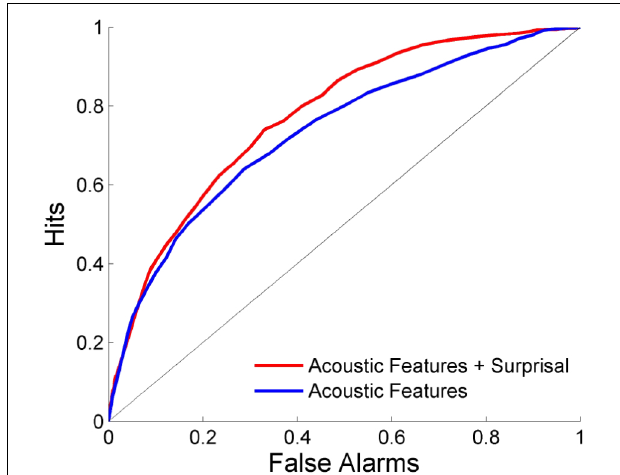
FIGURE 5 | Event prediction performance. Predictions are made using LDA on overlapping time bins across scenes. The area under the ROC curve is 0.775 with a combination of acoustic features and surprisal, while it reaches only 0.734 with acoustic features